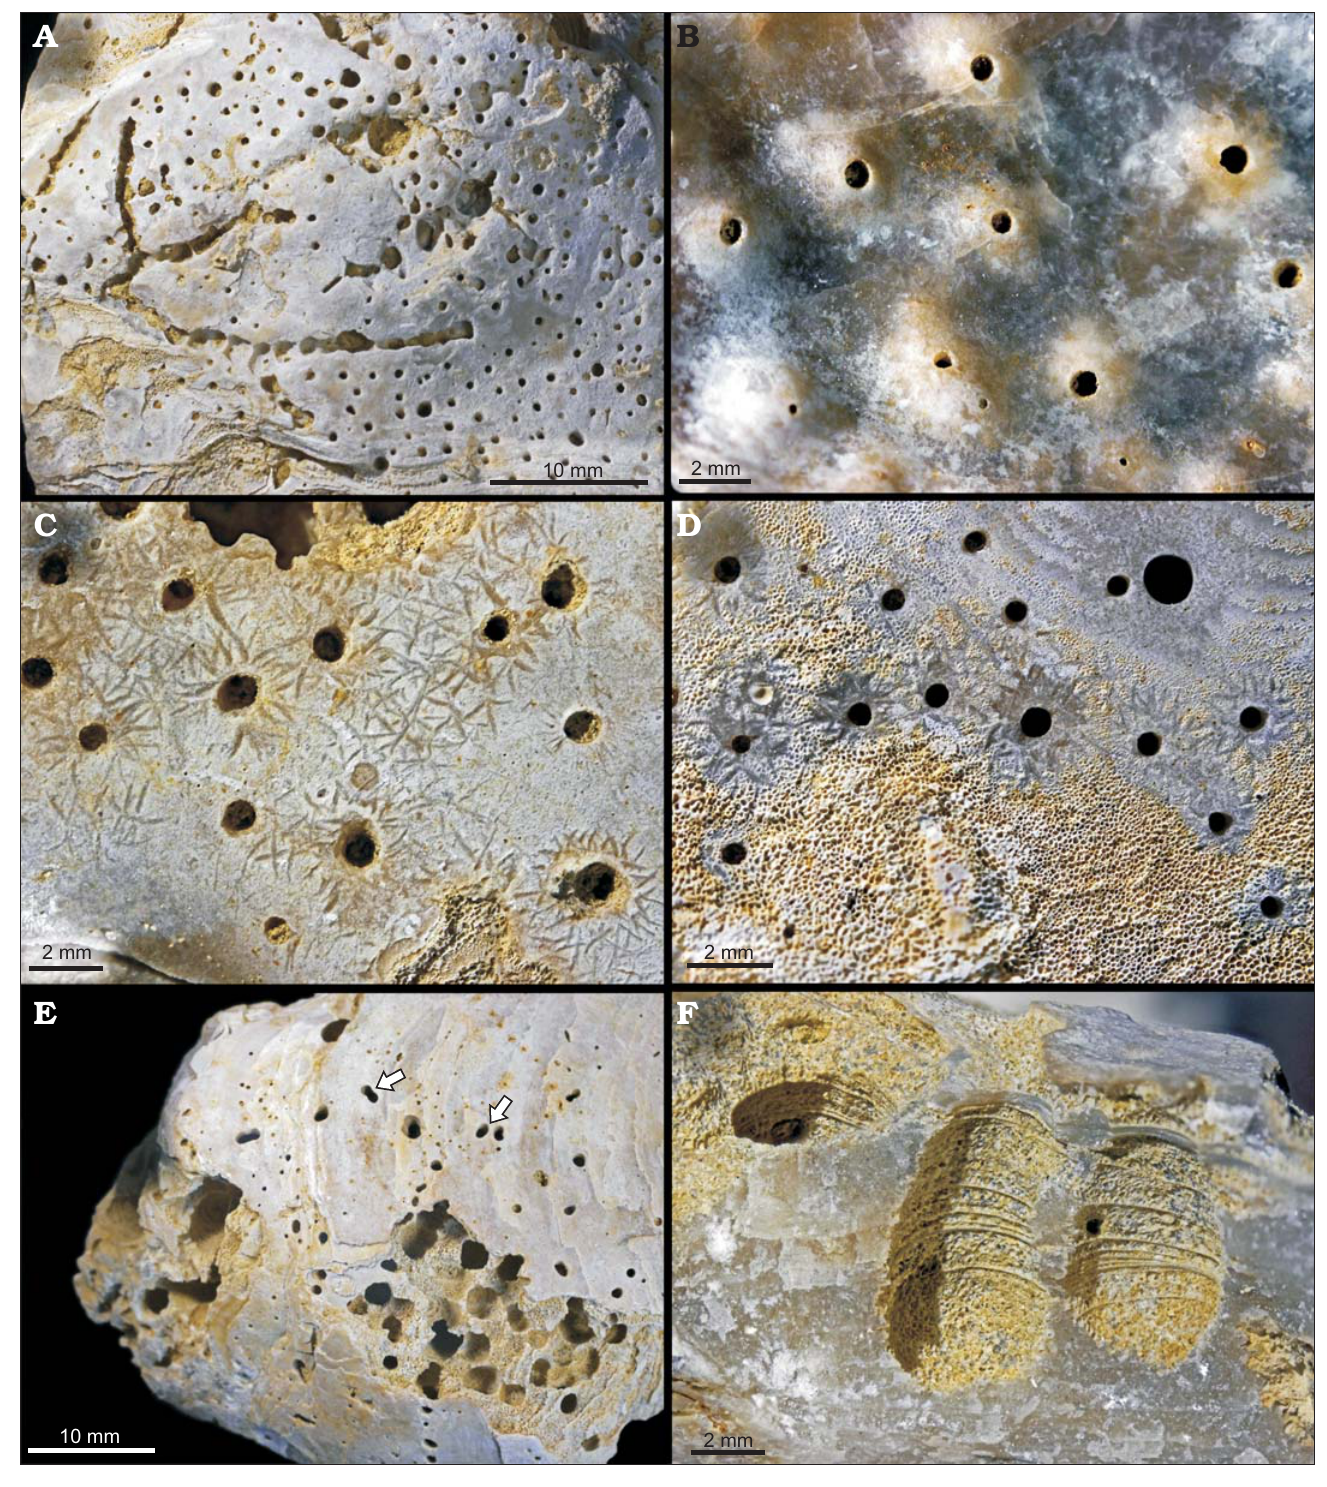
Fig. 2. Traces of scrapers and borers on oyster Pycnodonte biauriculata (Lamarck, 1819), unless otherwise specified, Marnes à Pycnodonte biauriculata Formation, Upper Cenomanian, Lycée Bellevue earthmoving works, Le Mans, Sarthe Department, France. A . Sponge boring Entobia cretacea Portlock, 1843, outer side of a LV, MHNLM 2015.2.207; identified by its long, straight camerate threads with aligned apertures and the roughly equidiametric and evenly spaced chambers. B . Sponge boring Entobia isp., inner side of a LV, MHNLM 2015.2.209; note the swellings and the discoloured areoles around the apertures, indicating a syn-vivo entobian infestation. C . Echinoid scraping traces Gnathichnus pentax Bromley, 1975, MHNLM 2015.2.182; these rather large G. pentax tend to concentrate around the entobian apertures. D . Echinoid scraping traces Gnathichnus pentax Bromley, 1975, MHNLM 2015.2.177; a rather small G. pentax , only present around the entobian apertures, the abrasion of the external layer of the shell brings the vesicular structure of the shell to light (lower part of the picture). E . Bivalve boring Gastrochaenolites cf. dijugus Kelly and Bromley, 1984, MHNLM 2015.2.223; most of the borers are concen-